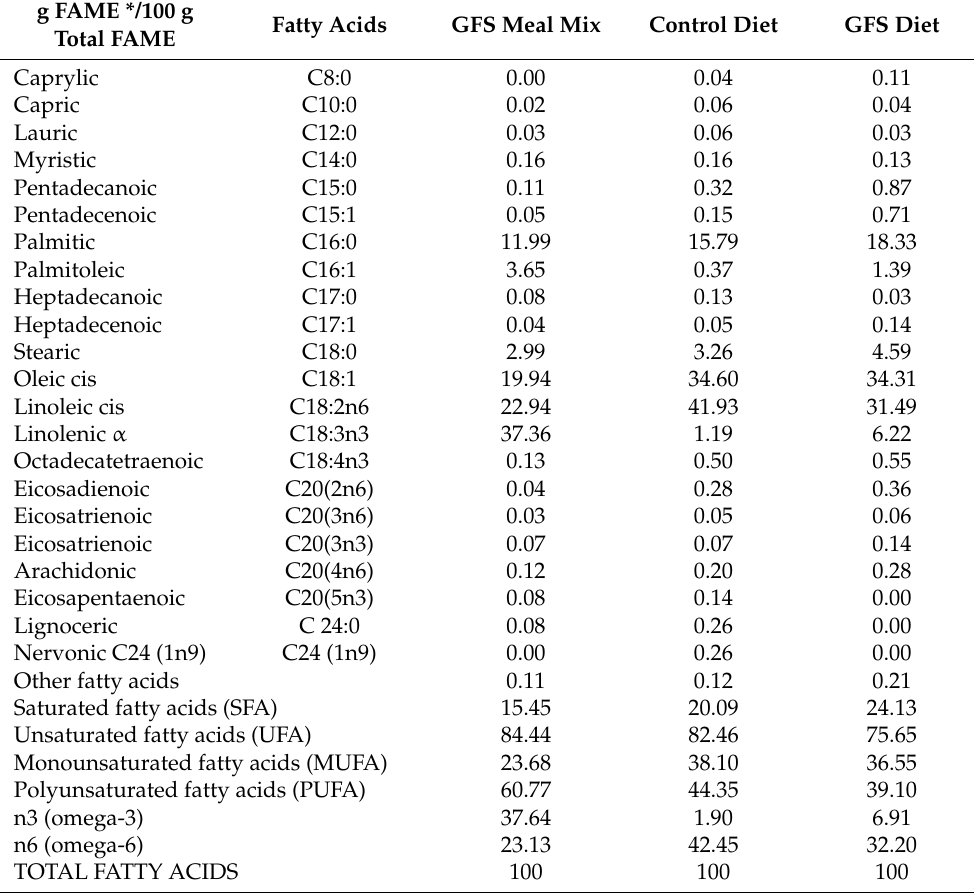
Table 3. Fatty acids content of the meal mix and the